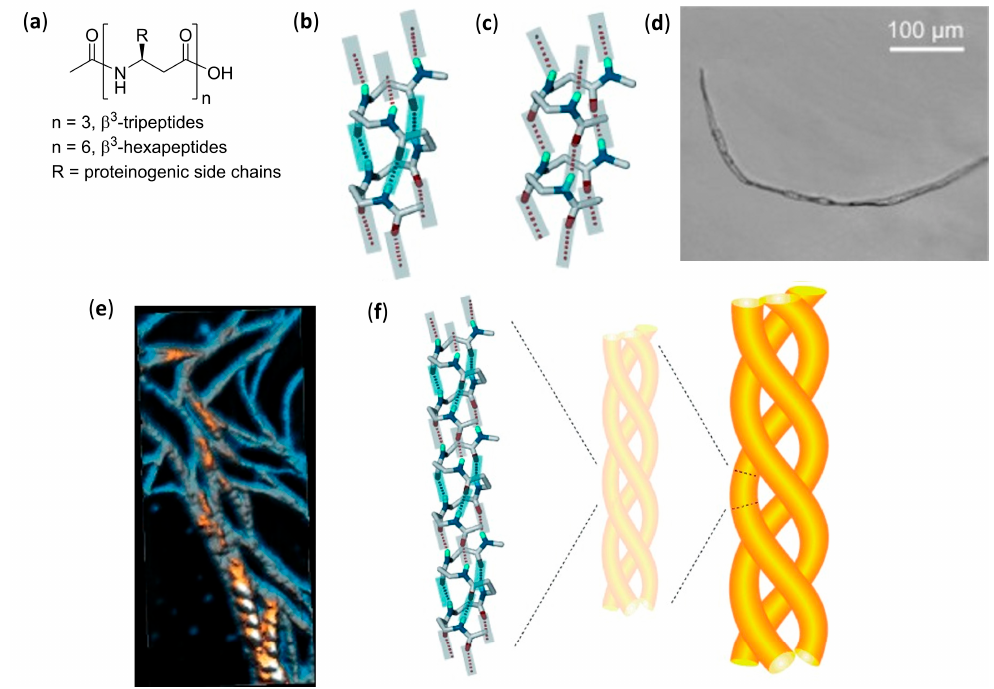
Figure 6. ( a ) Representative structures of β 3 -tripeptides (n = 3) and β 3 -hexapeptides (n = 6) (Refs. [120–122,128]); Intermolecular (grey) and intramolecular (cyan) hydrogen bonds in the crystal structures of ( b ) a β 3 -hexapeptide, and ( c ) a β 3 -tripeptide (side chains and unnecessary hydrogens omitted for clarity) (adapted with permission from Ref. [120]); ( d ) Microscopic fiber formed by the β 3 -tripeptide Ac- β 3 -hTrp- β 3 -hSer- β 3 -hIle-OH (adapted with permission from Ref. [120]); ( e ) 3D rendering of an AFM image of fibrils in a microscopic fiber of β 3